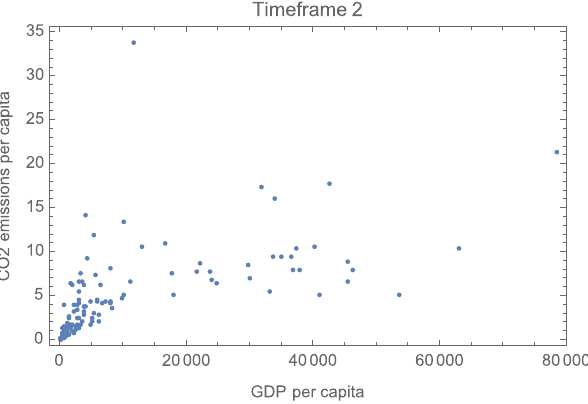
Fig. A.6. CO 2 as a function of GDP in time frame 2 for all countries.